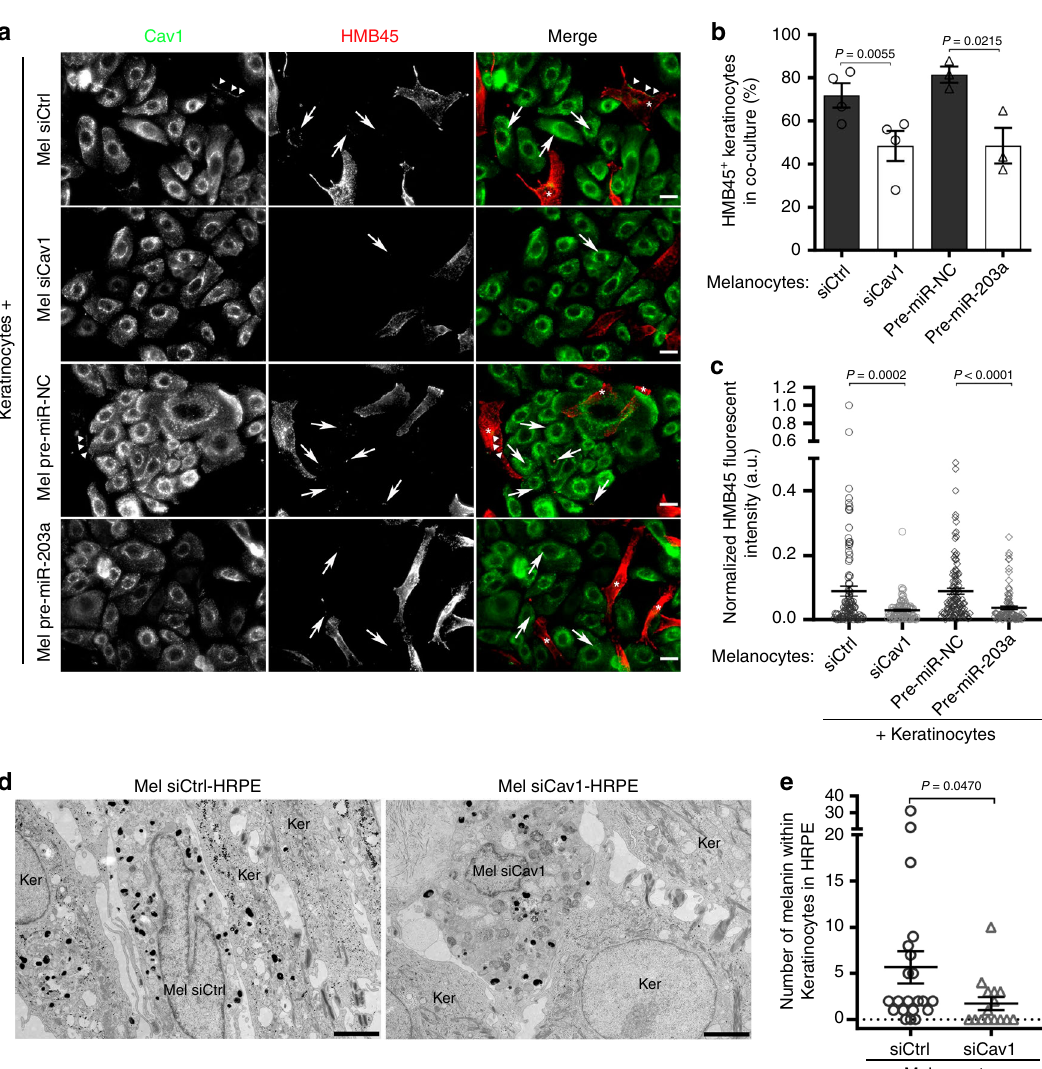
Fig. 4 Caveolae in melanocytes are necessary for melanin transfer in vitro and in tissue. a – c Melanocytes treated with Ctrl (control) or Cav1 (caveolin-1) siRNAs, pre-miR-NC (pre-miRNA-negative control) or pre-miR-203a (pre-miRNA-203a) for 5 days were co-cultured with keratinocytes for the last 2 days. a IFM images of the co-culture immunolabeled for Cav1 (caveolin-1, green) and HMB45 (premelanosome protein PMEL, red). Keratinocytes positive for HMB45-transferred melanin, arrows; melanocytes in merge panels, asterisks. Bars, 20 µ m. b Quanti fi cation of the frequency of keratinocytes positive for HMB45-positive structures in each condition. c Quanti fi cation of HMB45 fl uorescent intensity in individual keratinocytes positive in b . d Conventional EM micrographs of 9 days 3D-HRPE (human reconstructed pigmented epidermis) composed of keratinocytes and siCtrl- or siCav1-treated melanocytes. Bars, 2 µ m. e Quanti fi cation of the number of pigmented melanosomes in keratinocytes at the vicinity of melanocytes. Values are the mean ± s.e.m. b , c Four independent experiments for siCtrl and siCav1 and three independent experiments for pre-miR-NC and pre-miR-203a; e one experiment. b Two-tailed paired t -test; c , e , two-tailed unpaired t -test with Welch ’ s correction. See also Supplementary Table